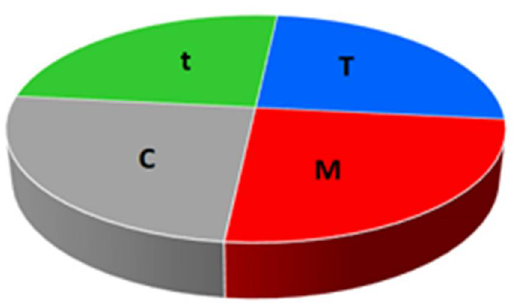
Figure 3. Washing factors according to Sinner’s cycle: t—time, T—temperature, M—mechanics, C—chemistry.